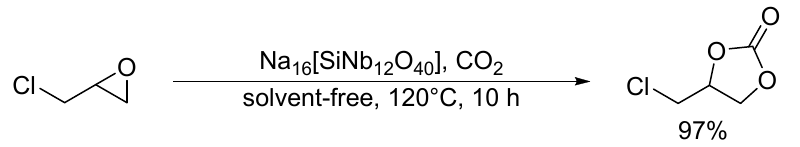
Scheme 6. Cycloaddition of propylene oxide and CO 2 catalyzed by (DBUH) 3 [NbO 3 (O 2 )].